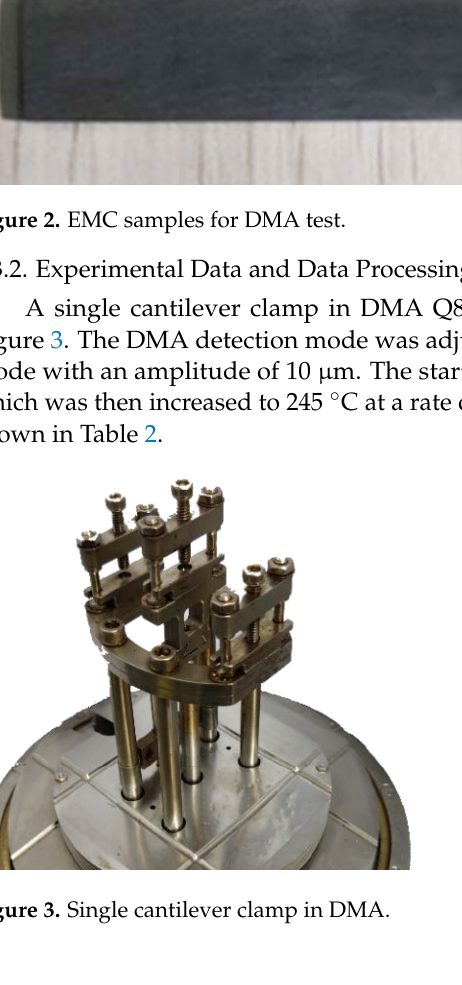
Figure 3. Single cantilever clamp in